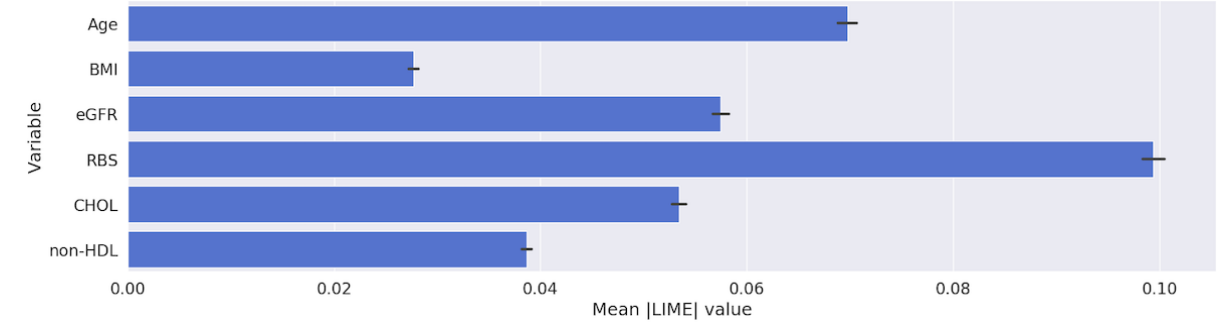
Figure 7. Relative importance of predictors obtained from multilayer perceptron trained with longitudinal data using LIME. CHOL: total cholesterol; eGFR: estimated glomerular filtration rate; LIME: local interpretable model-agnostic explanations; non-HDL: non–high-density lipoprotein; RBS: random blood sugar.